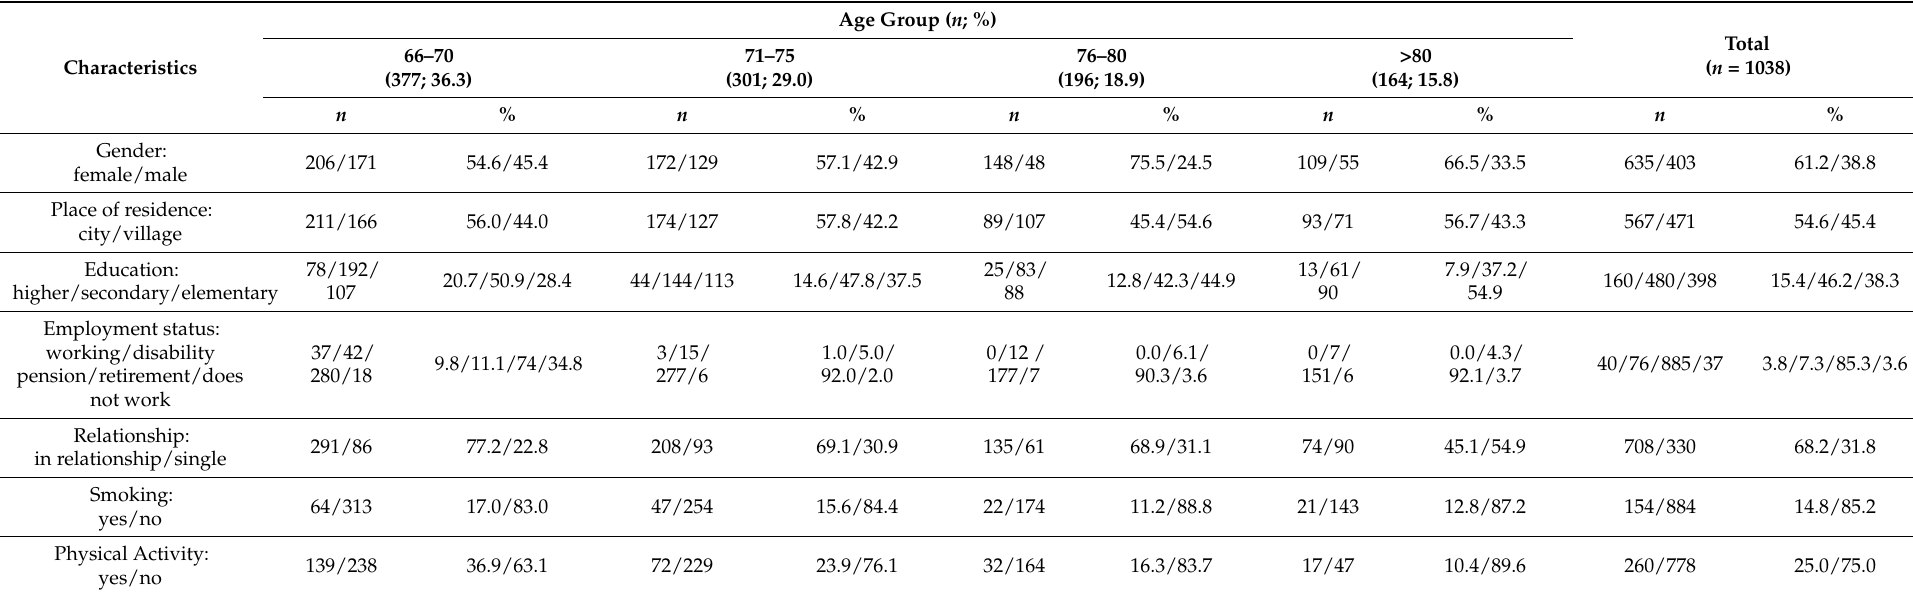
Table 1. General characteristics of the study group of the